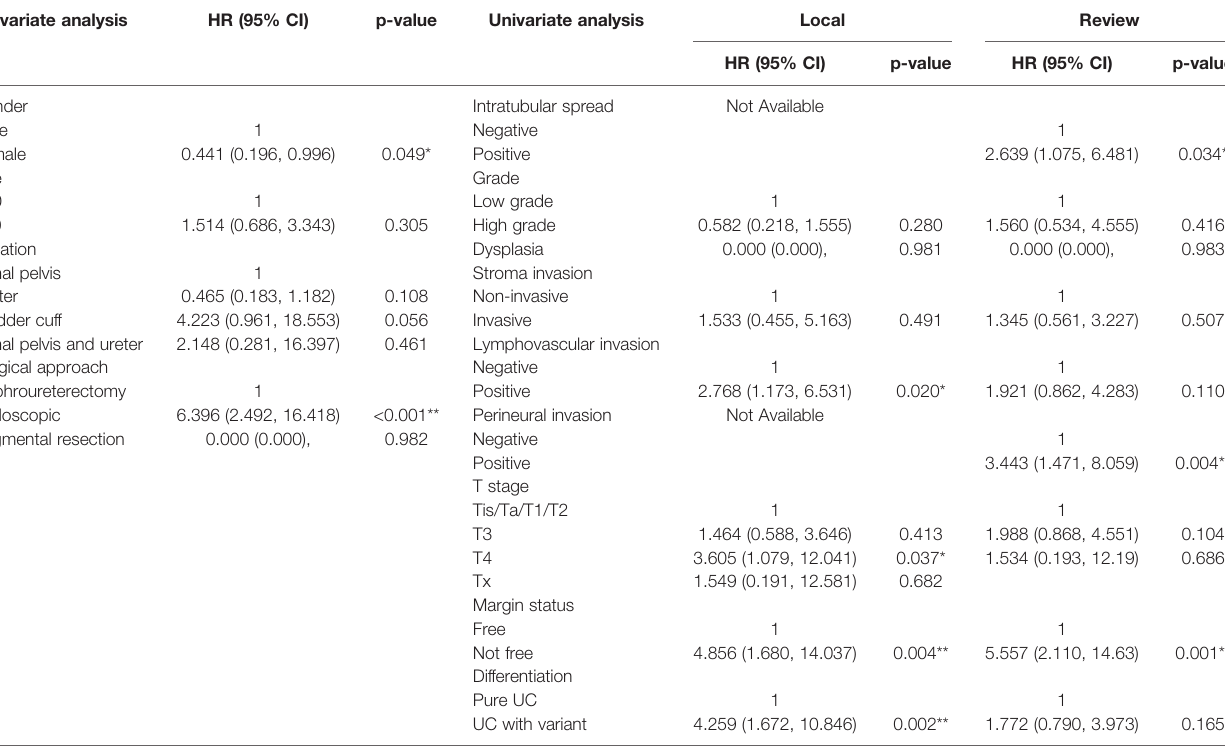
TABLE 7 | Comparative univariate disease-free survival analysis of upper tract urothelial cancer patients according to local and review pathology. Univariate